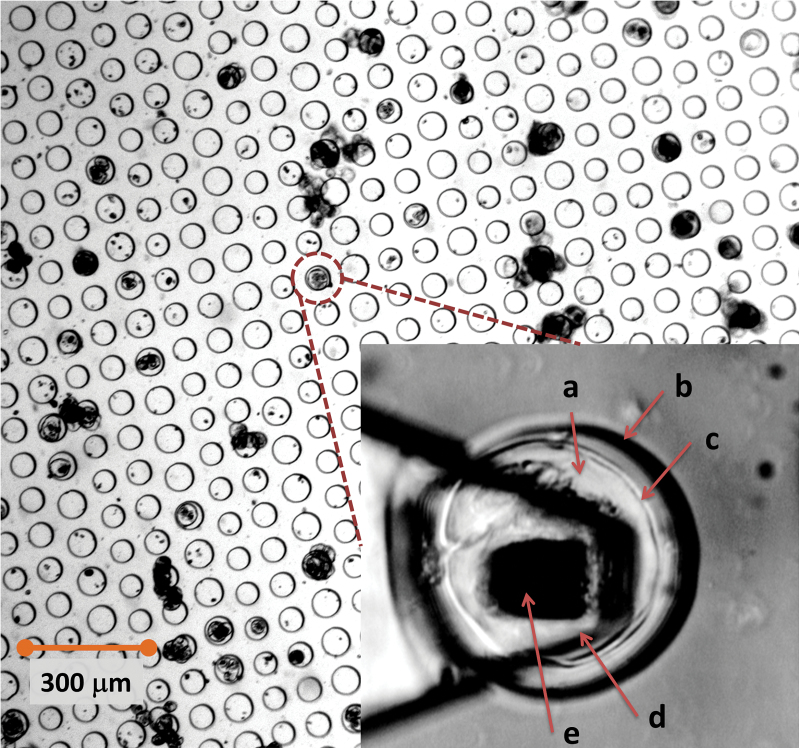
A bright-field image of a microwell array showing the distribution of cells and cell/clusters that sedimented into the well. The chance occurrence of a single cell sinking into the microwell of the matching size was utilized for AFM nanoindentation measurements. In the inset, a dual illumination (bright-field and reflected light) optical micrograph of a L. multiflorum SCC (a) confined within a PDMS microwell (b). The cell wall (c) is visible as a shell surrounding the cell. An AFM cantilever (d) is positioned above the cell so that the tip (e) is positioned approximately above the apex of the cell. (This figure is available in colour at JXB online.)